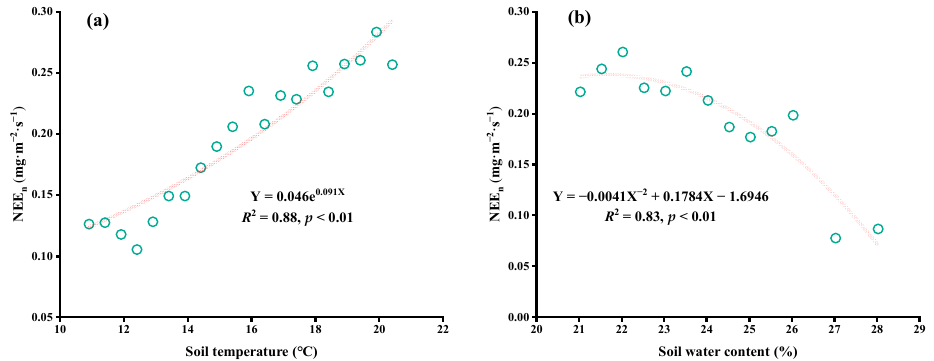
Figure 6. ( a ): The relationship between NEE n and Soil temperature. ( b ): The relationship between NEE n and soil water content.